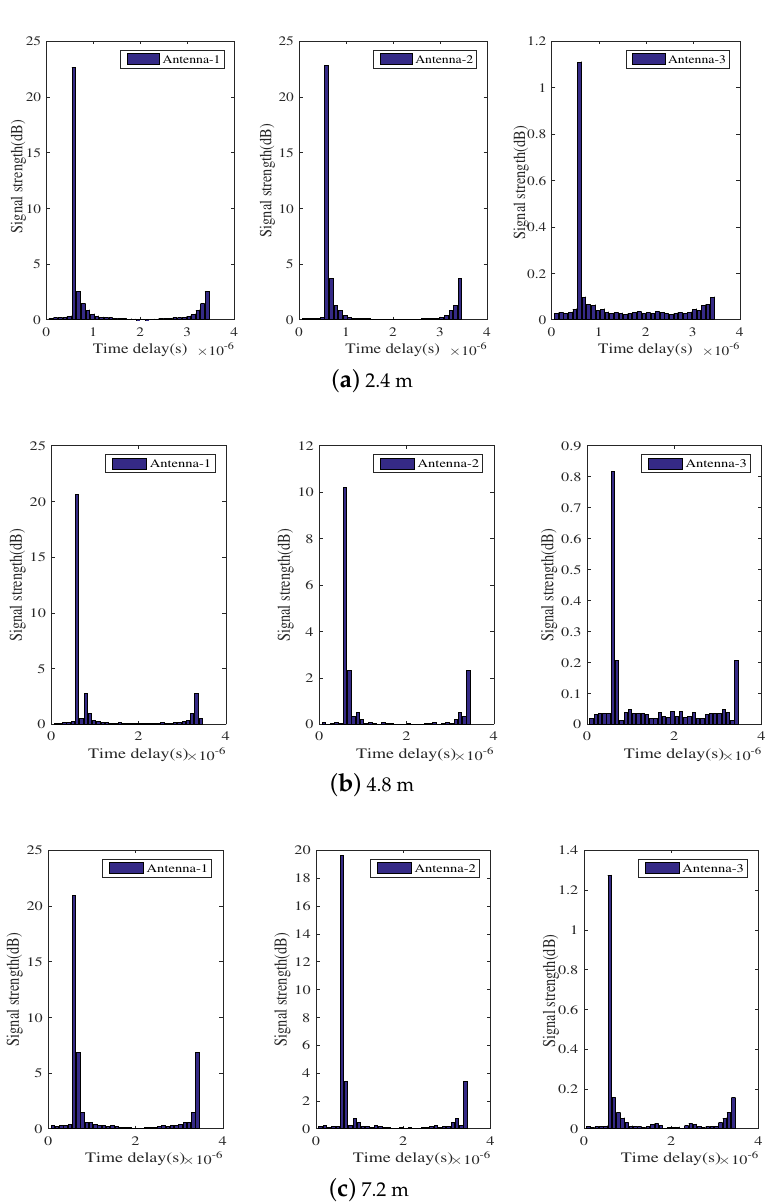
Figure 4. Time domain diagram of the indoor laboratory at different